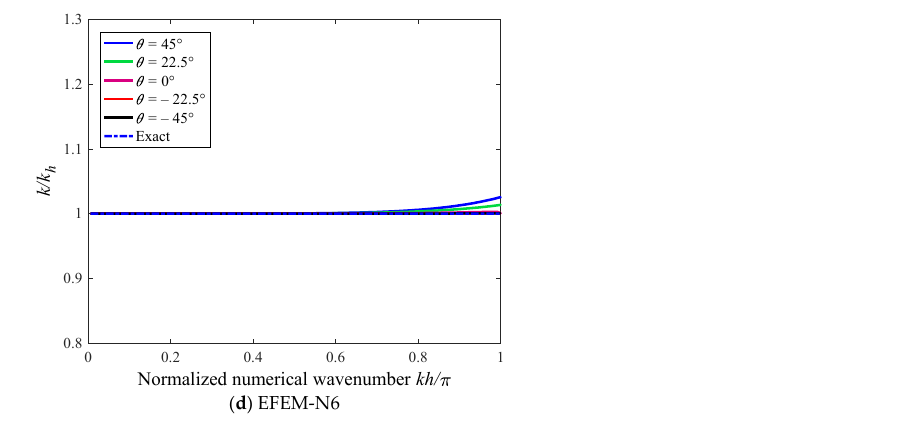
Figure 2. The numerical dispersion error solutions versus the nondimensional wave number kh from the various numerical techniques.